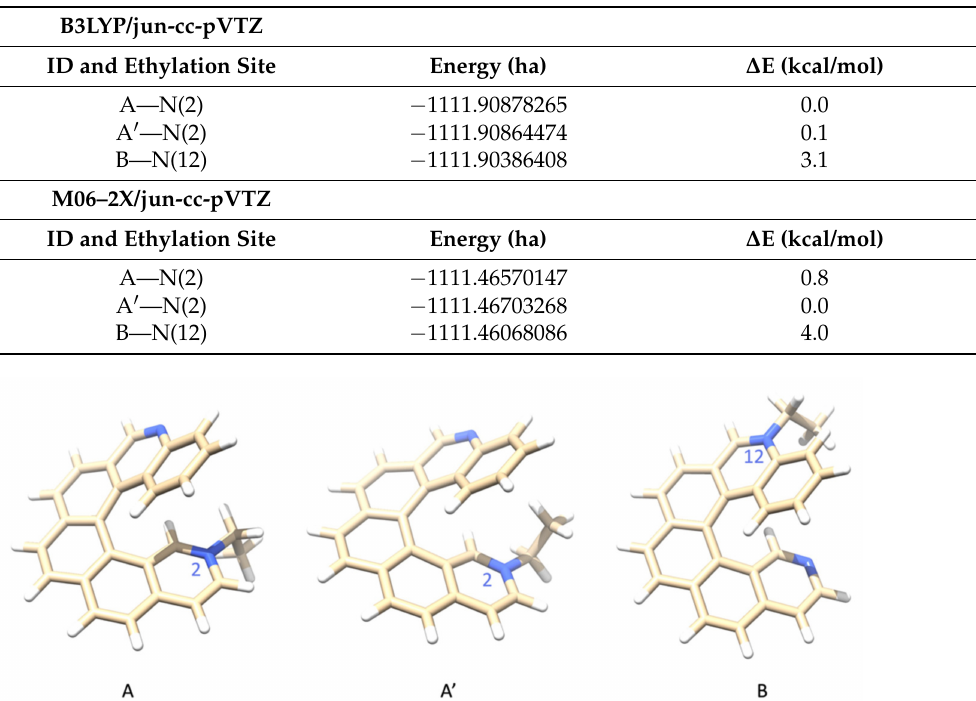
Table 2. DFT-computed energies (hartree units) and relative stabilities (kcal/mol) of the ethylated derivatives of 4 . The labels of the isomers correspond to the structures reported in Figure 8.